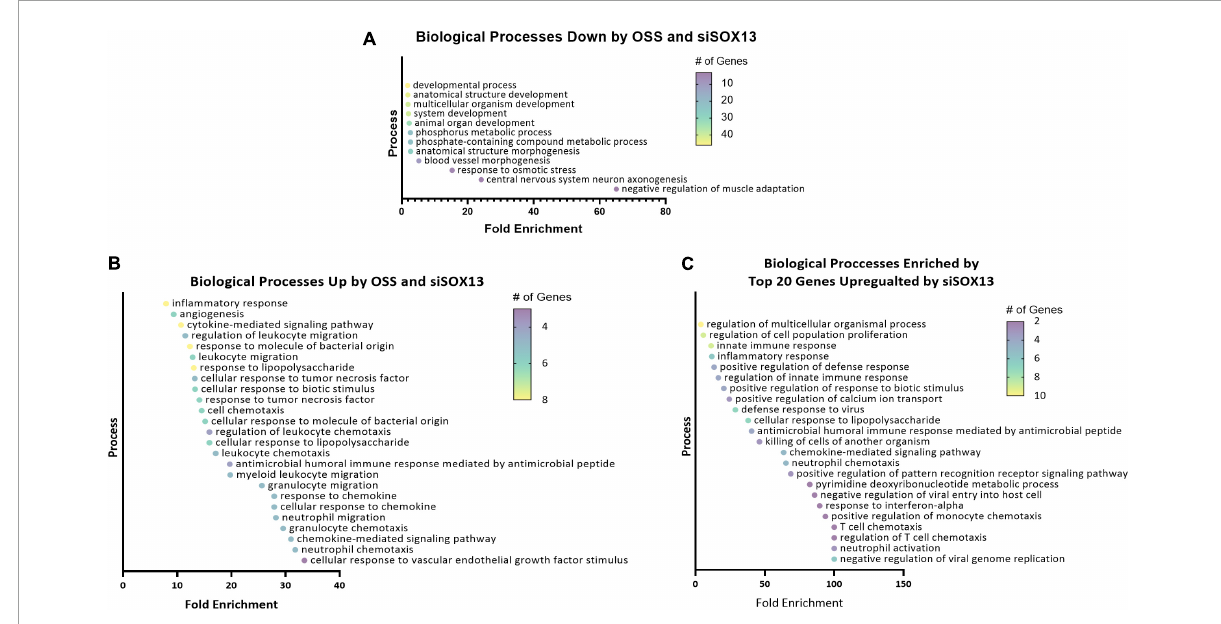
FIGURE5 Gene ontology analysis of shear-dependent and SOX13-dependent genes. Biological processes enriched by the 94 commonly downregulated genes by OSS or siSOX13 in ULS condition (A) , the 40 commonly upregulated by OSS or by siSOX13 (B) , and the top 20 genes upregulated by siSOX13 regardless of shear conditions (C) are shown. All biological processes listed were significant by p